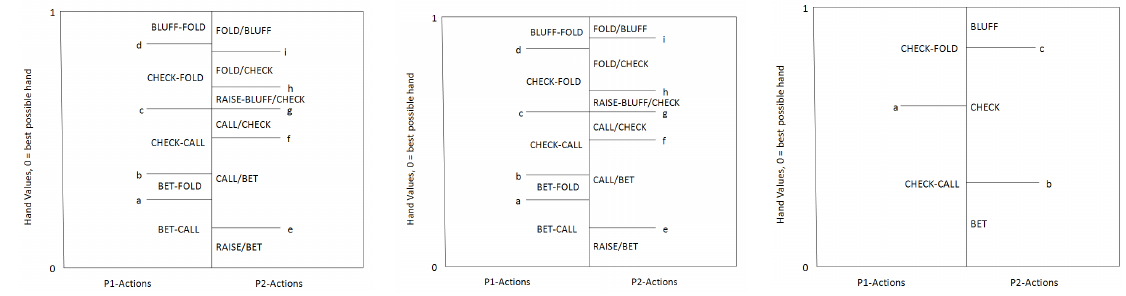
Figure 2. Three qualitative models for two-player limit Texas hold’em river endgame